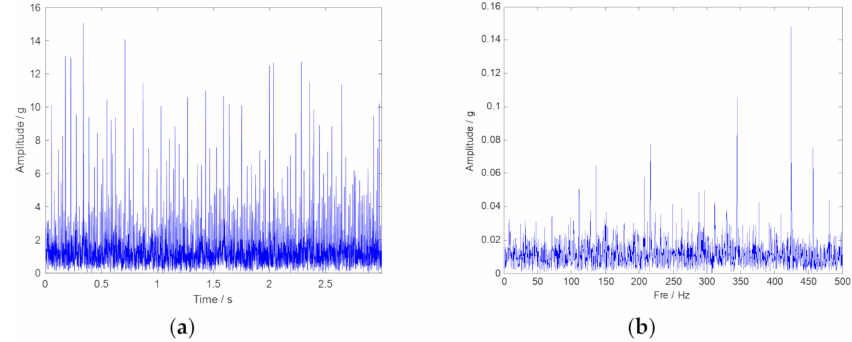
Figure 9. The time-domain and frequency-domain spectra of the envelope signal. ( a ) Envelope signal in time-domain; ( b ) Envelope signal in frequency-domain.